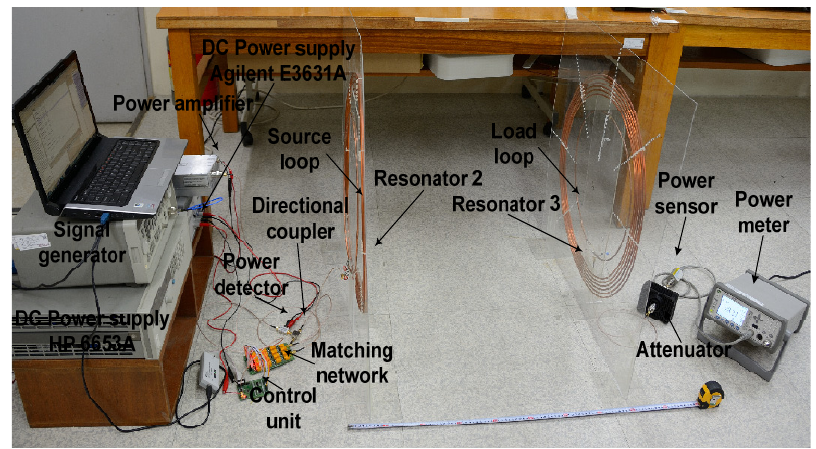
Figure 10. Experimental setup for the proposed WPT system.